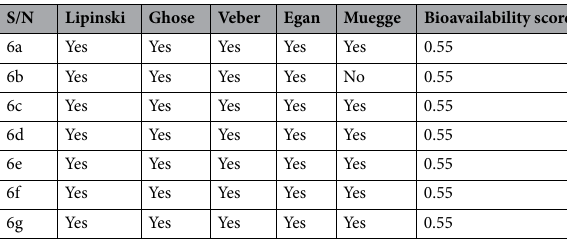
Table 5. Druglikeness.